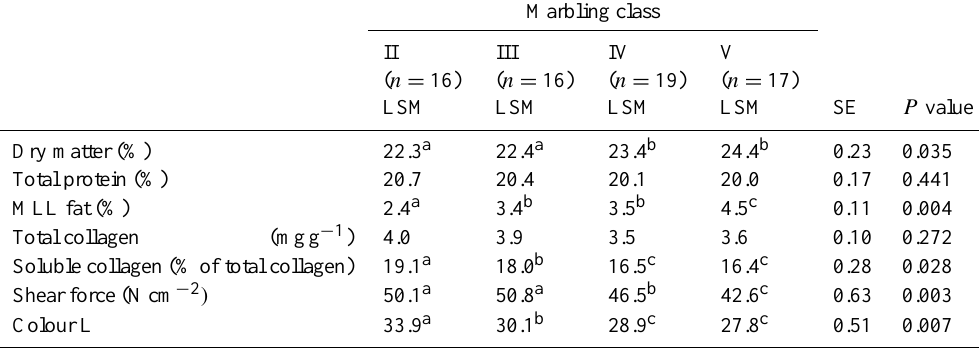
Table 2. Chemical composition and physical properties of longissimus lumborum